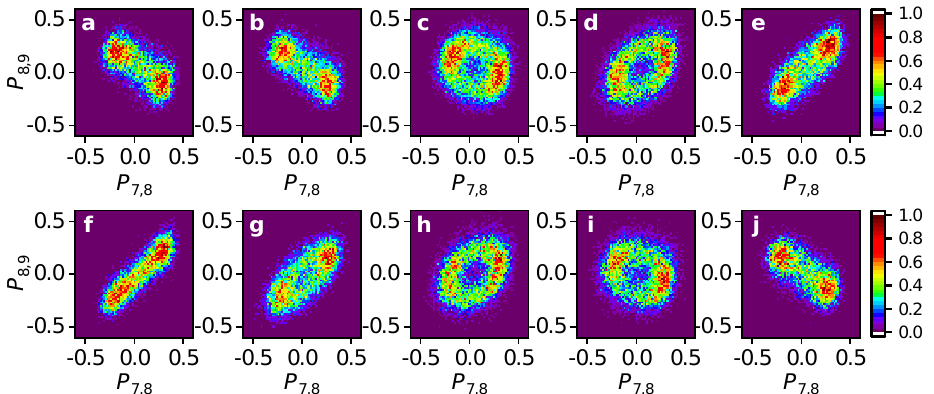
Figure 2. Experimental correlation plots for a phase scan using PS 4 in the three-harmonic case. ( a – j ) Evolution of the correlation plots of the oscillating components of the sidebands ( P 7,8 , P 8,9 ) for increasing values of the delay τ s 4 introduced by the phase shifter PS 4 . The delay τ s 4 introduced by the phase shifter PS 4 affects the phase of the harmonic H 7 . The color scale indicates the density of single-shot experimental points normalized to unity for each